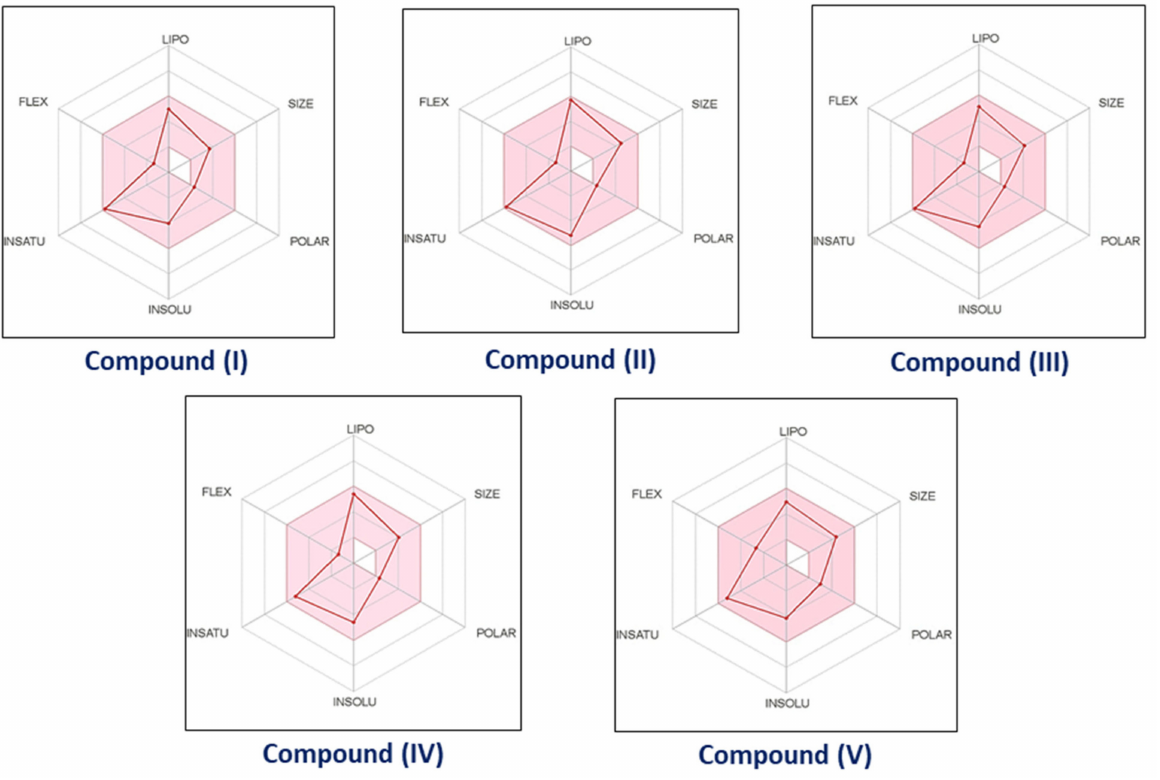
Figure 10. The Bioavailability Radar of the compounds ( I – V ). The optimum range for each property is shown by the pink